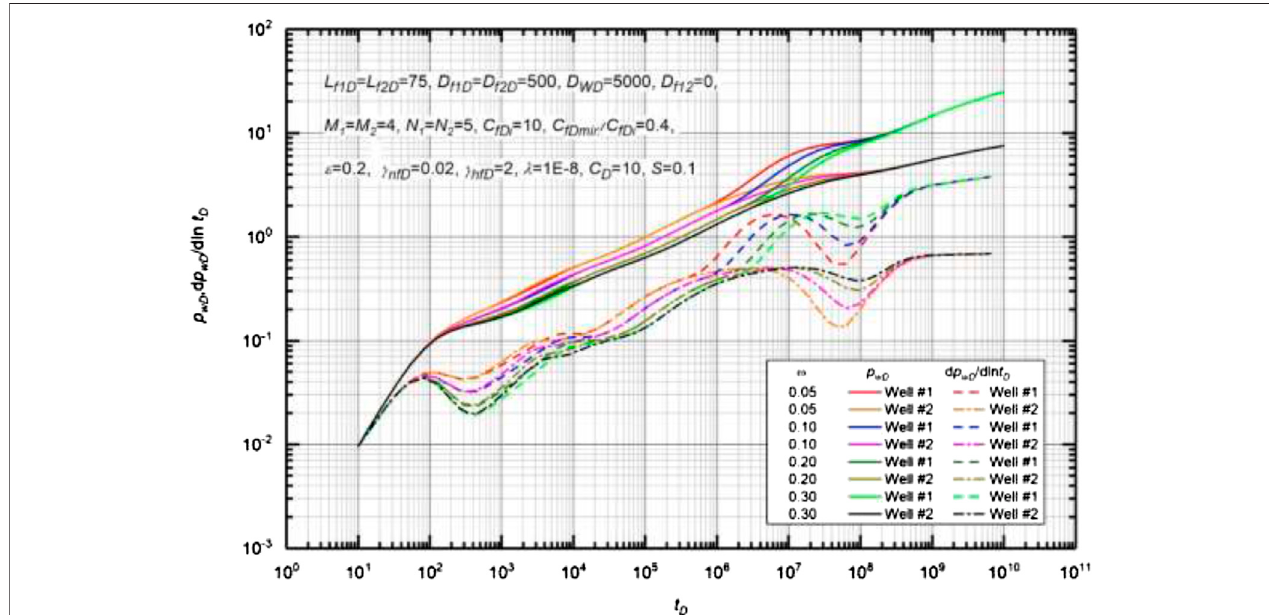
FIGURE 15 | Effect of storage ratio on the transient pressure for